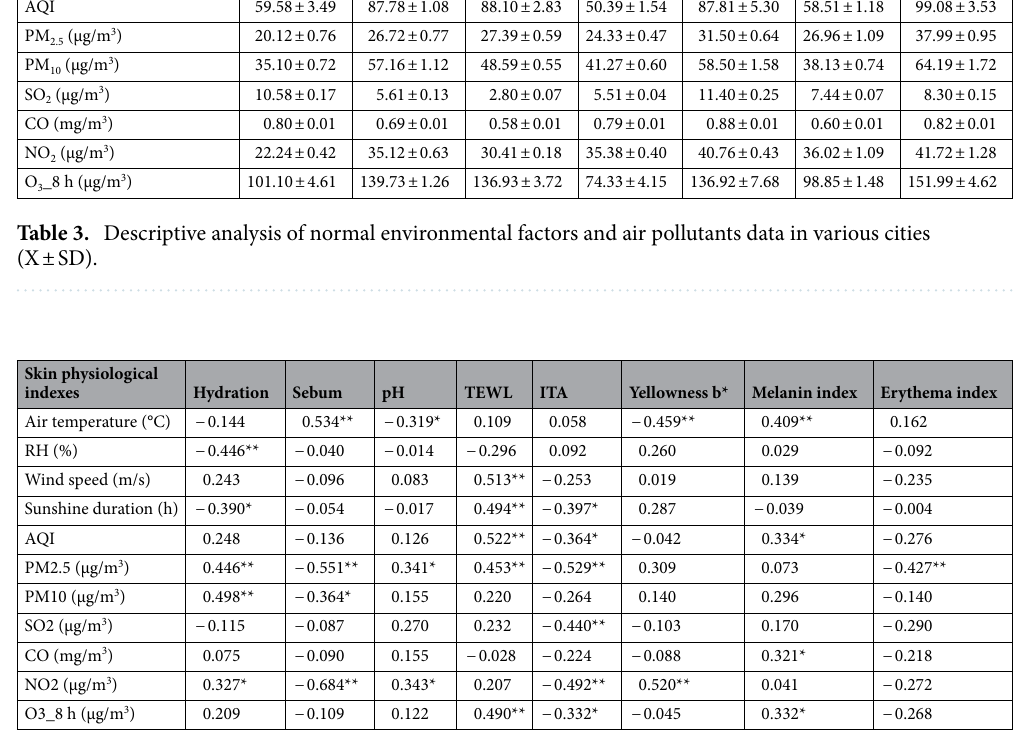
Table 4. Correlation analysis between environmental data and skin physiological index data (X ± SD). *Indicates a significant correlation at the 0.05 level. **Indicates a significant correlation at the 0.01 level.